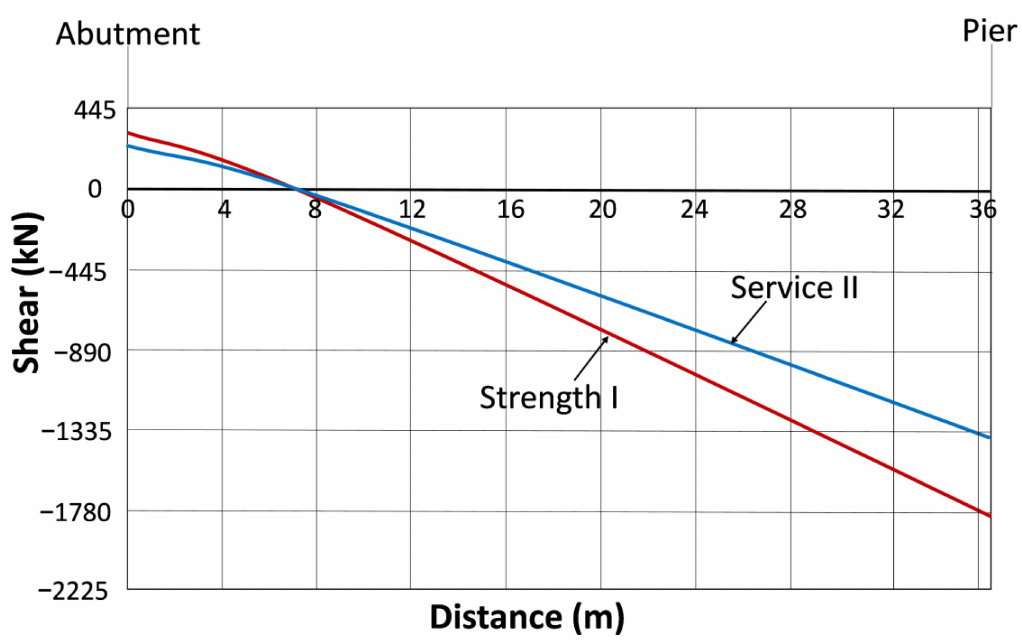
Figure 14. Cross section and plan view of the steel bridge girder of Application 2.